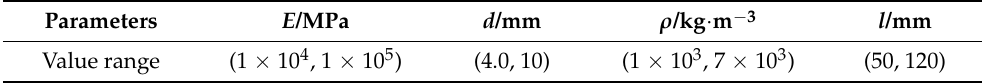
Table 1. The ranges of the structure and material parameters of the finger.